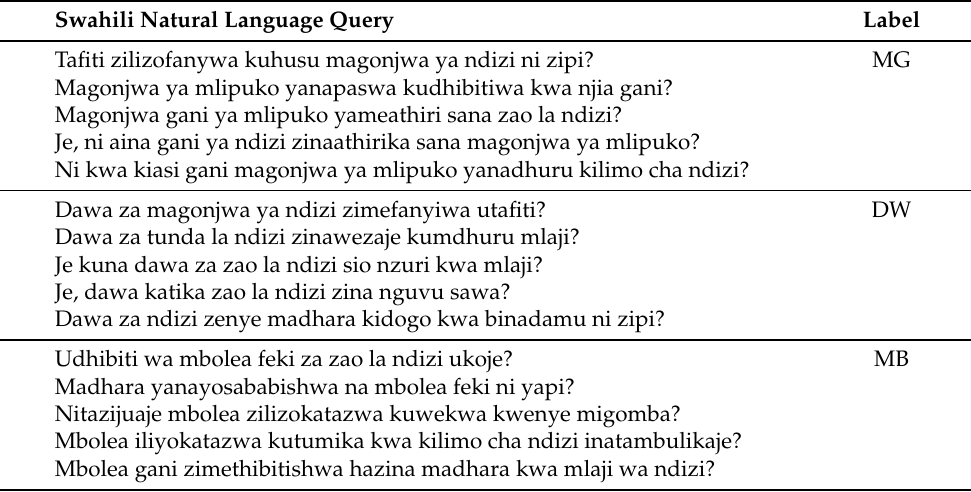
Table 3. Sample Swahili natural language queries collected from farmers. Swahili Natural Language Query